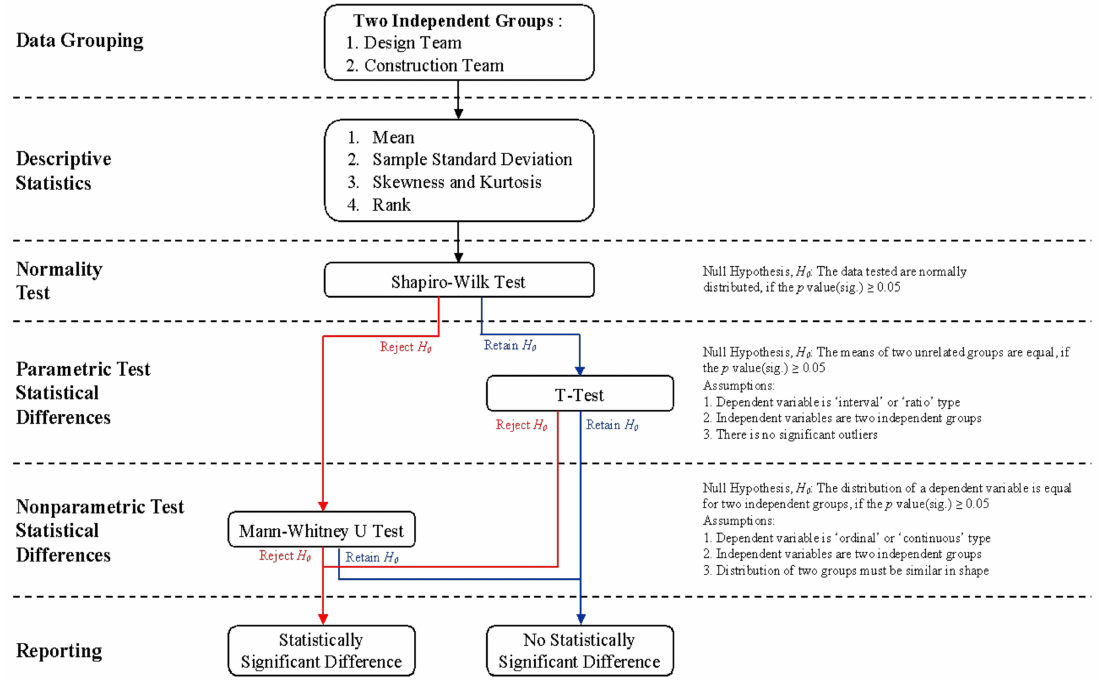
Figure 2. Flow chart of the adopted statistical tests for two independent